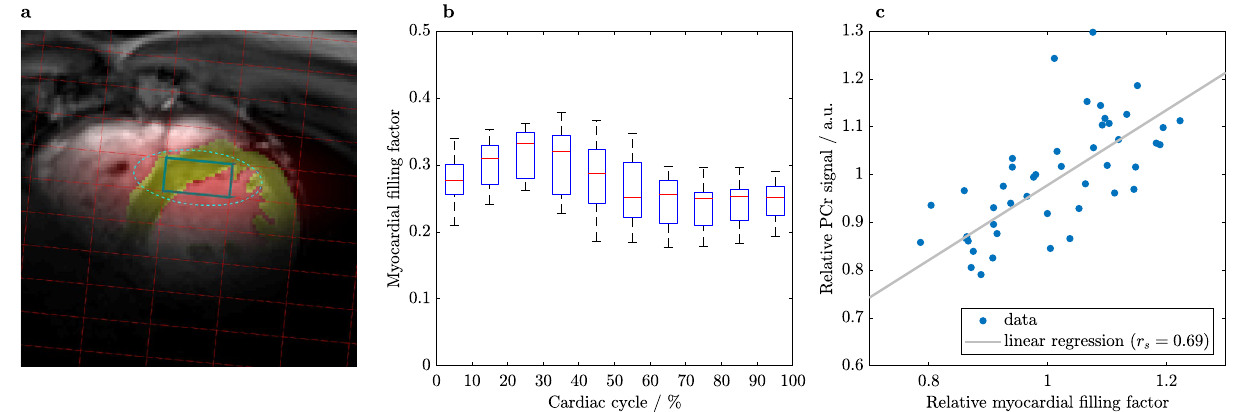
Figure 4. ( a ) Segmentation of left ventricular myocardium (yellow) and other tissue (red) convolved with the spatial response function (SRF) of the marked voxel (nominal: 13.75 × 27.5mm 2 in-plane). The dashed line shows the isocontour of the SRF at 64 % after filtering. The image depicts a central short axis slice during diastole with a filling factor of 29.2 % for the marked voxel. ( b ) The myocardial filling factor, i.e. myocardial volume / sensitive voxel volume, for all selected voxels and volunteers. ( c ) Correlation of the PCr signal (normalized to the untriggered signal) and the filling factor (normalized to the mean over the cardiac cycle) for all volunteers, scan times and voxels. Line depicts linear regression with r s = 0.69